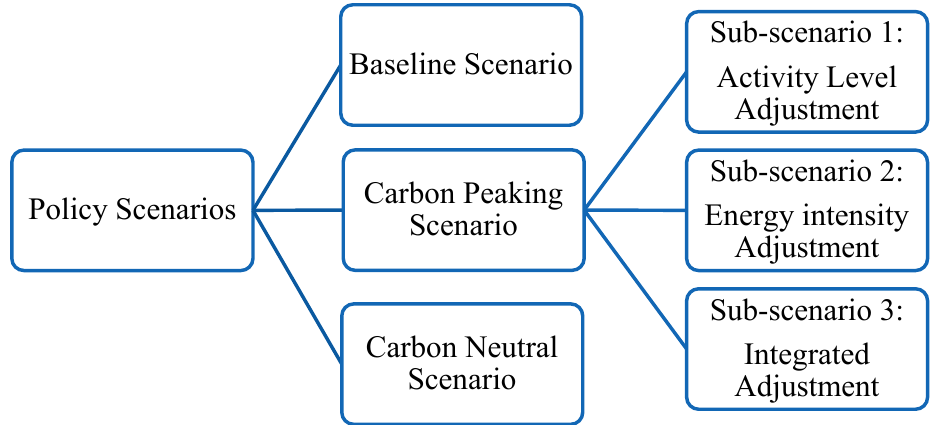
Figure 7. The structure of scenarios and sub-scenarios.